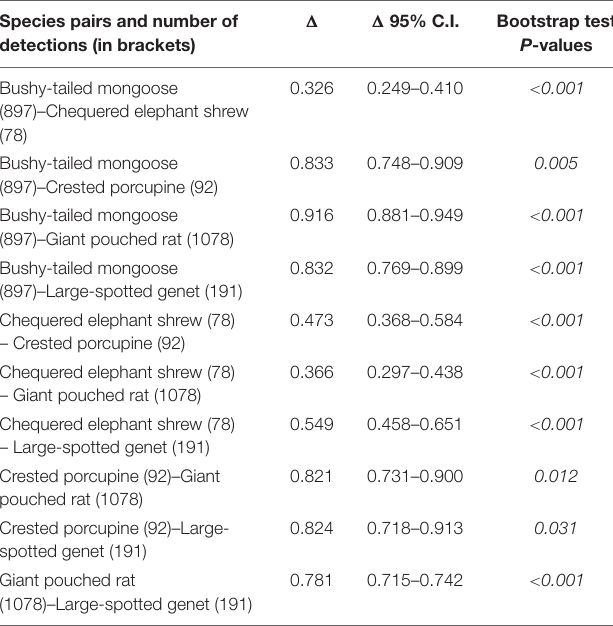
TABLE 3 | Estimates of temporal overlap in activity patterns ( (cid:49) ± 95% C.I.) for pairs of the five most common meso-mammal species in the Issa Valley. (cid:49) (cid:49) 95% C.I. Bootstrap test Species pairs and number of detections (in brackets) P